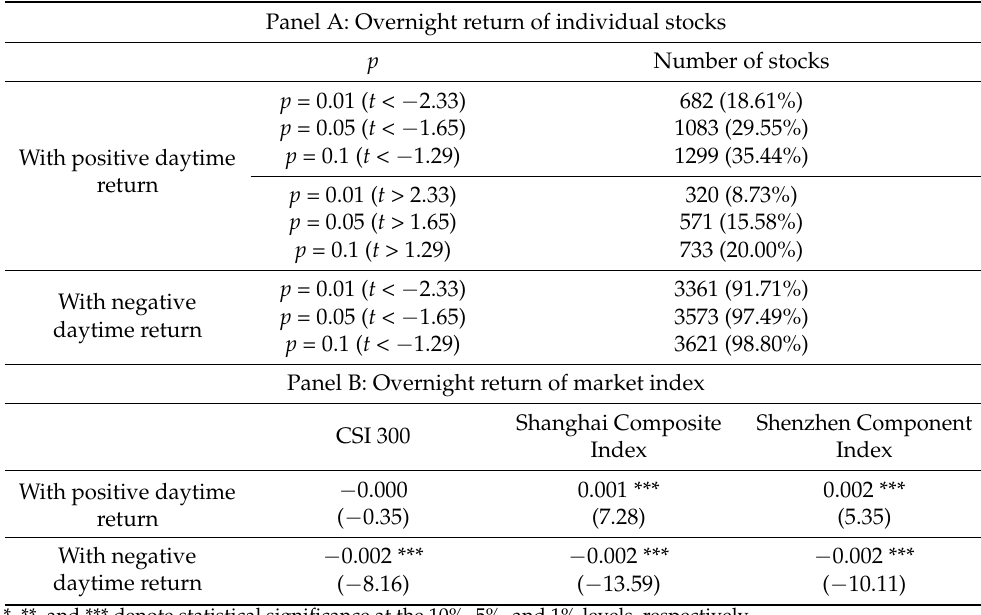
Table 3. Tests for asymmetry in the overnight return anomaly in Chinese markets. Panel A shows the overnight return of stocks with positive and negative daytime return, respectively, from January 1995 to December 2018. “ p ” indicates the significance level and “Number of stocks” indicates the number of stocks with negative return at each significance level. Panel B shows the overnight return of representative indexes with positive and negative daytime return,